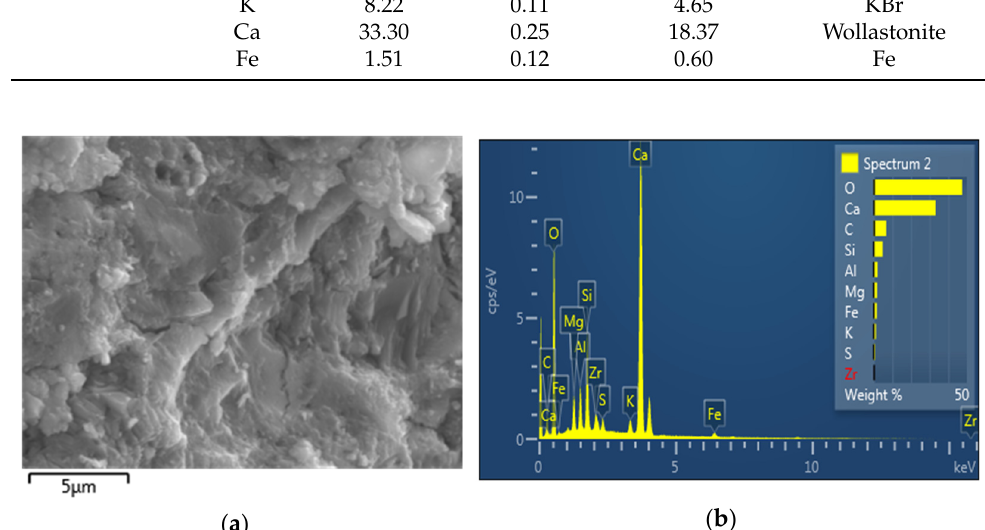
Figure 10. EDS results of plain paste: ( a ) SEM image; ( b ) EDS spectrum.